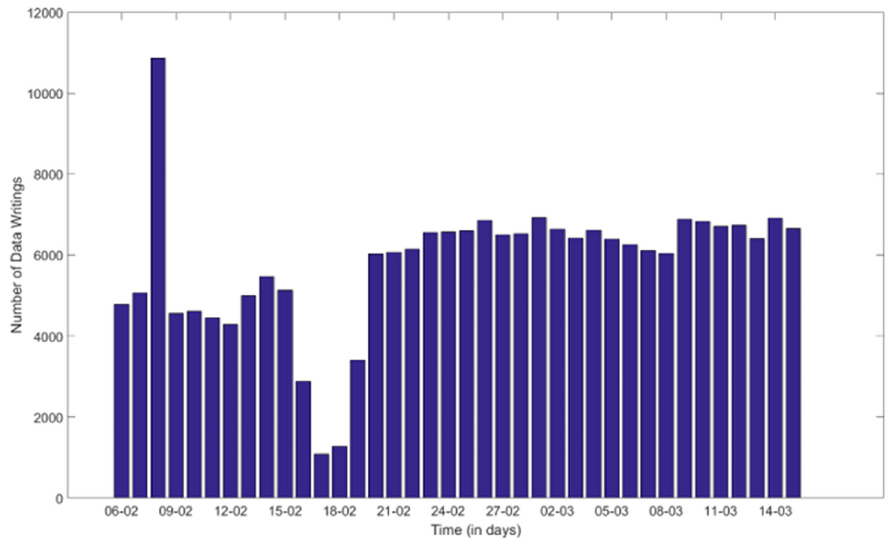
Figure 12. Observations’ writings per day during the analyzed period.